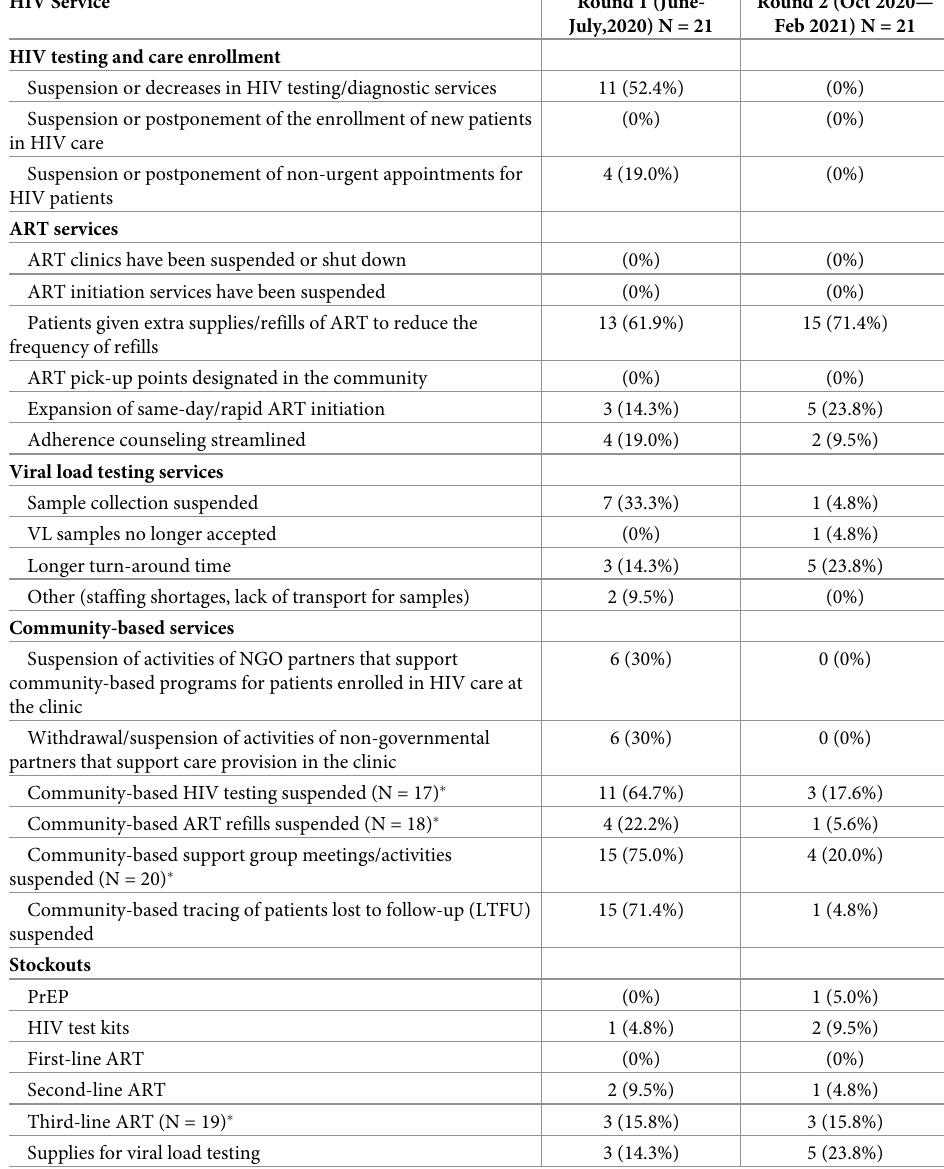
Table 3. Changes in HIV-related services and capacity at Central Africa IeDEA sites,